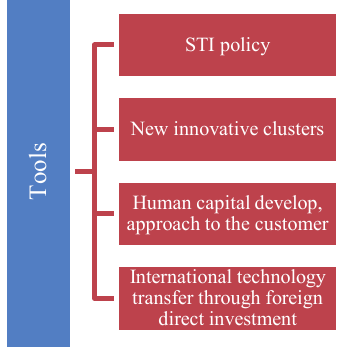
Fig. 3. Innovation commercialization tools in